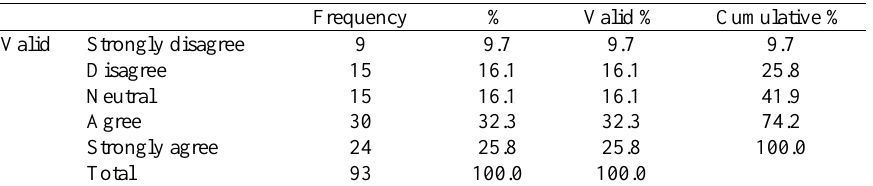
Table 3 Students who felt too shy to comment during the face-to-face lectures I feel shy to make comments during the face-to-face